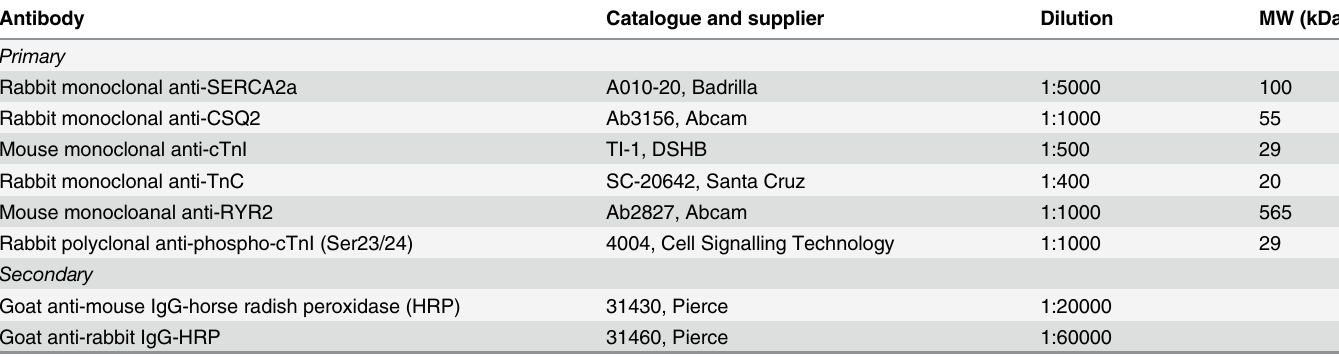
Table 2. Antibodies used for Western blot